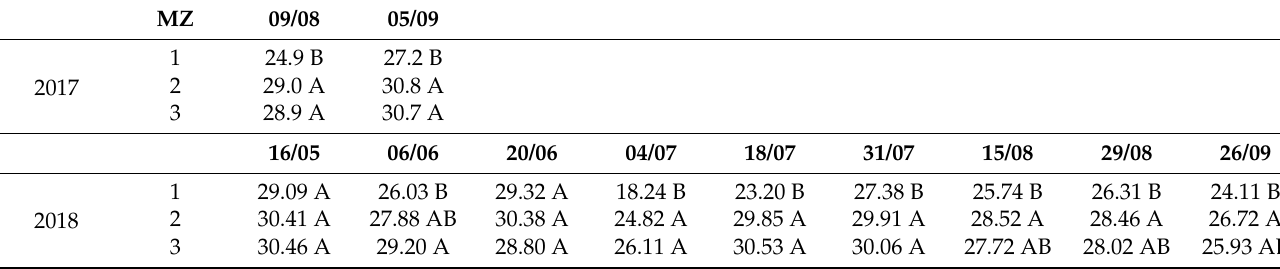
Table 3. Canopy cover for each management zone (MZ) during 2017 and 2018. Measurement was done first by calculating NDVI in vine rows, then calculating the canopy coverage of each MZ. Each value is the mean of 22 random points created to account for spatial autocorrelation. Data were analyzed by ANOVA. Different letters represent significant differences among MZs, means were separated using the Tukey–Kramer HSD test ( α =